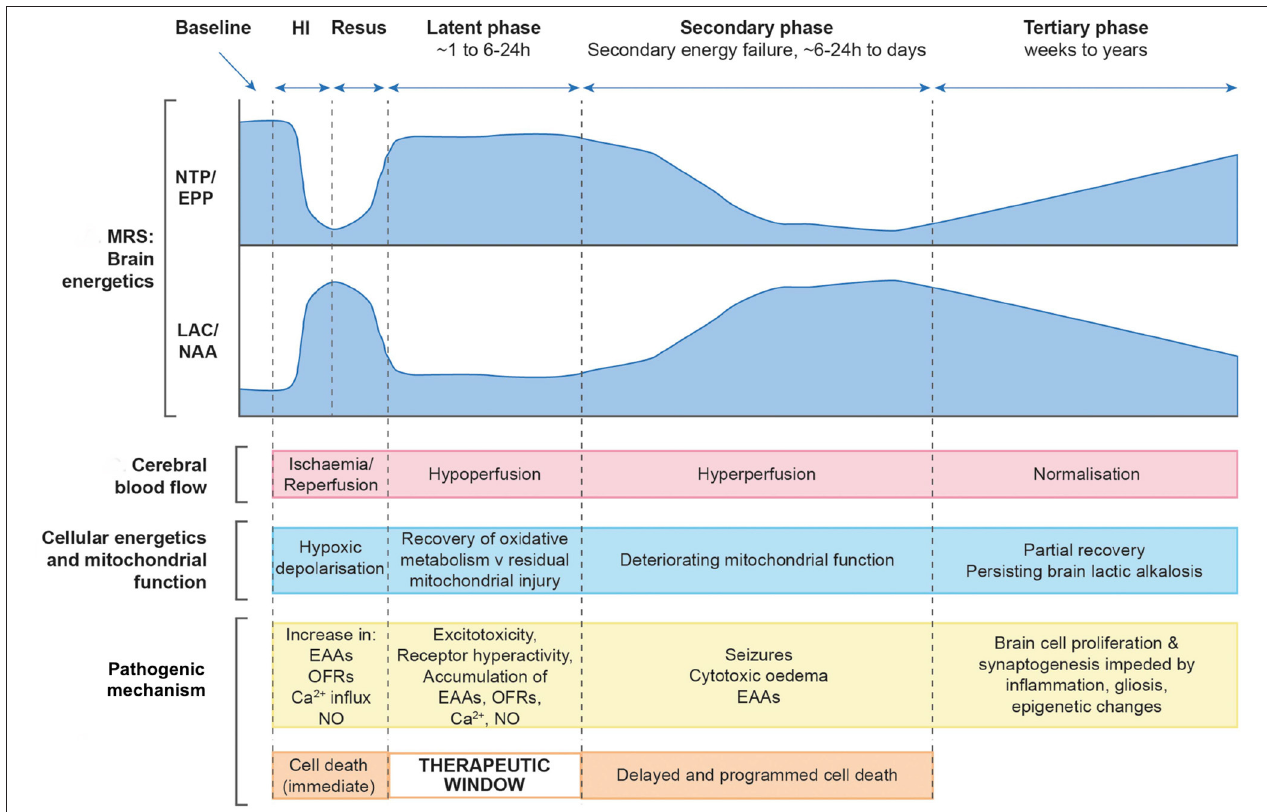
FIGURE 1 | Schematic diagram illustrating the different pathological phases of cerebral injury after hypoxic- ischaemic (HI) insult. Changes in magnetic resonance spectroscopy derived markers of brain energetics (NTP/EPP from 31 P MRS and Lac/NAA from 1 H MRS, NTP, nucleotide triphosphate; EPP, exchangeable phosphate pool; Lac, lactate; NAA, N acetyl aspartate) with biphasic pattern of energy failure, cerebral blood flow, cellular energetics and mitochondrial function, pathogenic mechanisms occurring at each phase and cell damage with associated therapeutic window. Image modified from Hassell et al. ( 9).